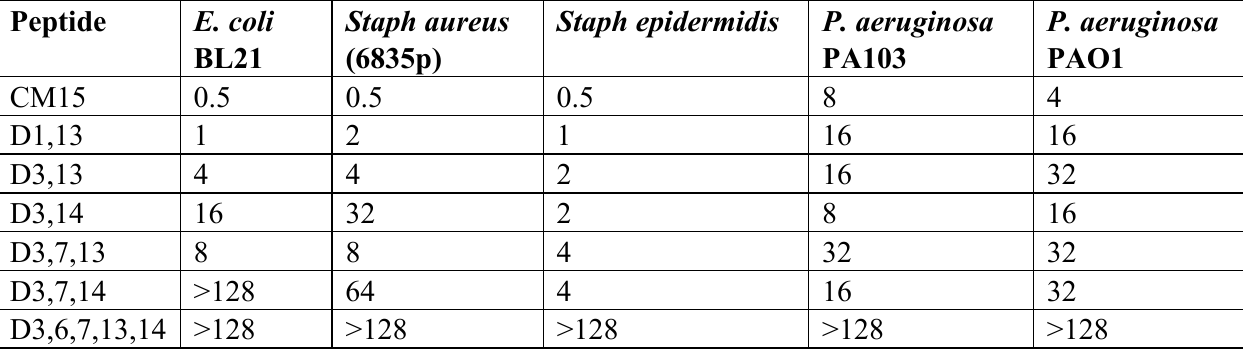
Table 2. Minimal inhibitory concentrations (µM) of CM15 and its D-lysine diasteromers.